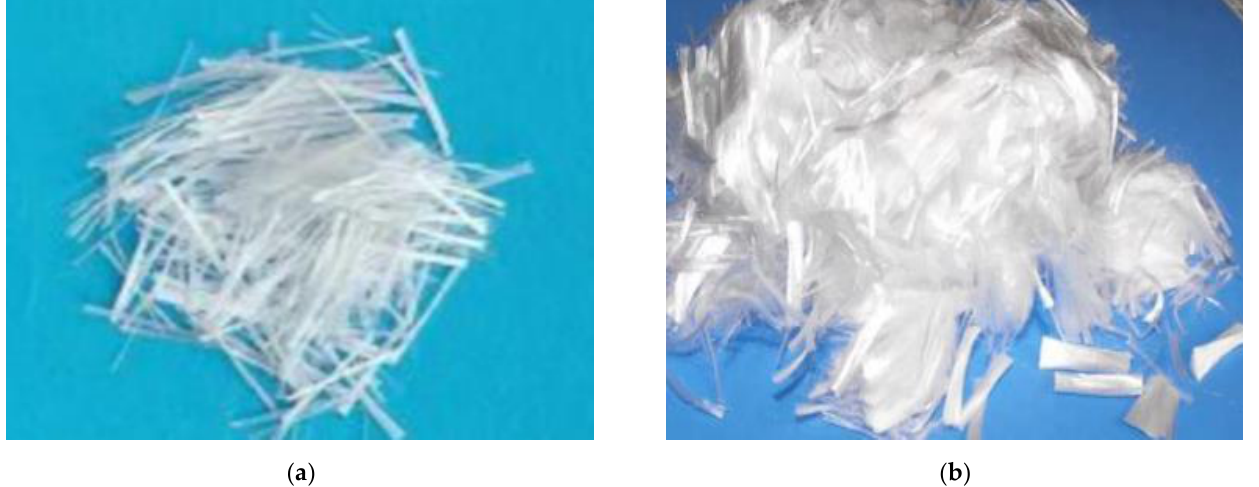
Figure 2. ( a ) Glass fiber and ( b ) nylon fiber.